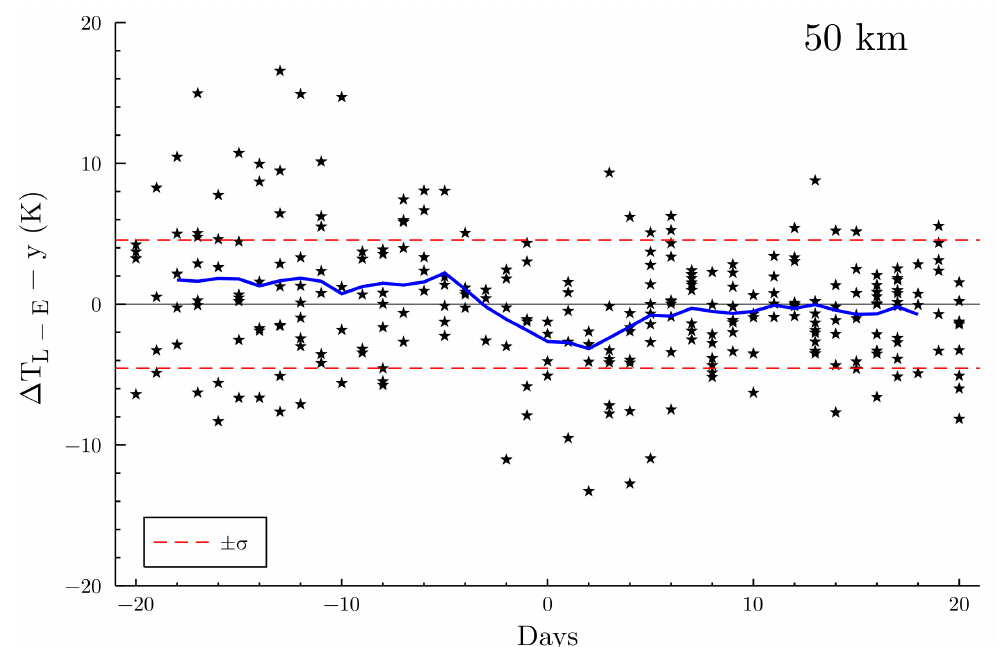
Figure 9. Evolution of the temperature differences at 50 km between the LiDAR and the ECMWF corrected by the linear regression 20 d before and after the mean zonal mean wind at 60° N and 10 hPa became inferior to 10 m.s − 1 . The standard deviation computed over all values (red dashed lines) and the moving mean (blue solid line) computed over five days are